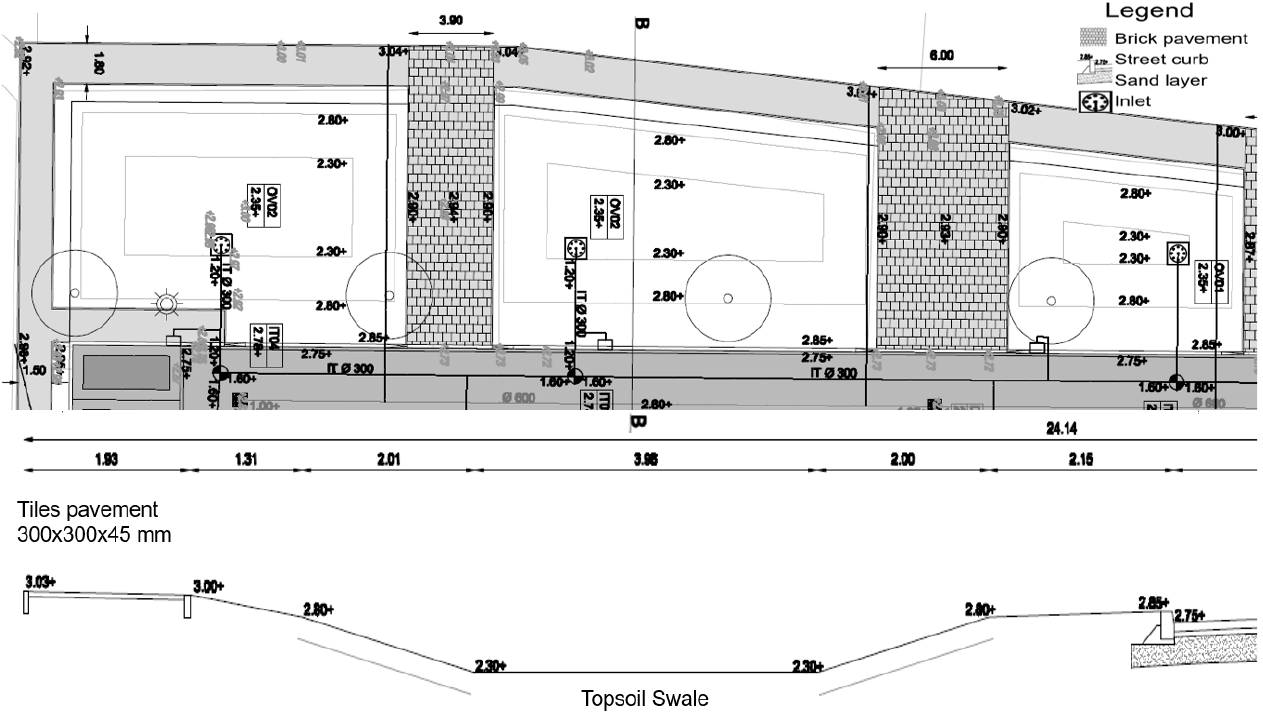
Figure 5. Swale 1 ( left ) to 3 ( right ) and cross ‐ section B ‐ B (swale 2).